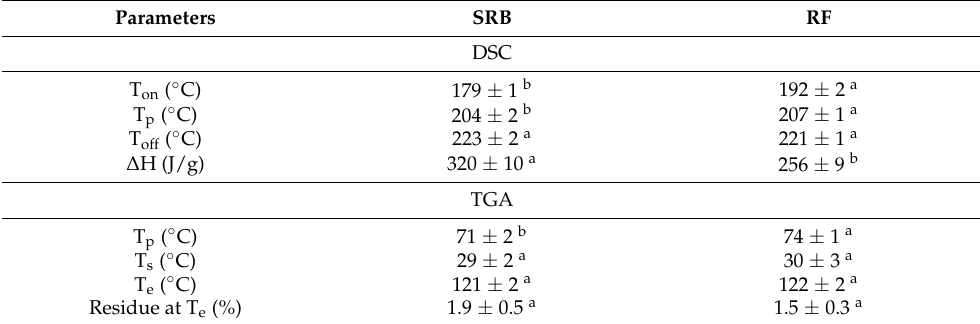
Values are presented as mean ± standard deviation ( n = 3), different lowercase superscript within the same row indicate a significant difference of means according to Tukey’s honest significant difference (HSD) test